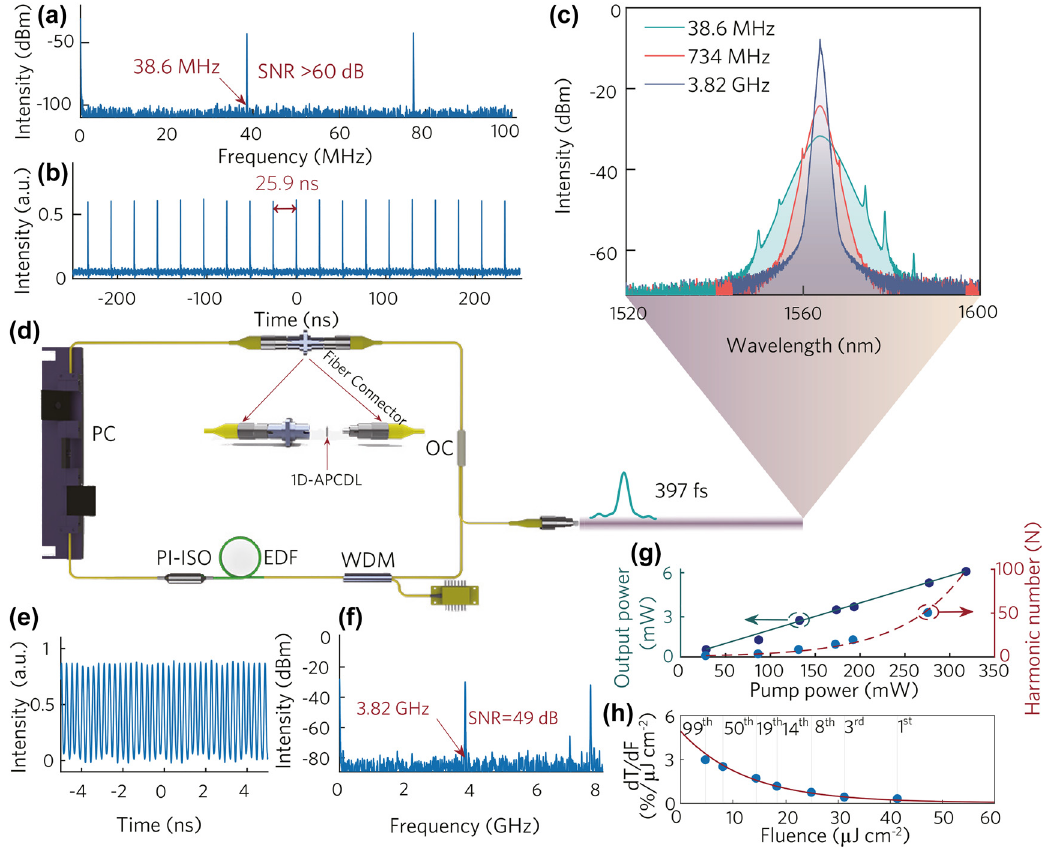
Figure 7: Application of 1D-APCDL in ultrafast fiber laser. (a) RF spectrum (fundamental frequency), (b) pulse train, (c) mode-locked spectra of different orders, (d) cavity schematic, (e) pulse train (99th), (f) RF spectrum, (g) the curve of output power and harmonic order varying with pump power, and (h) first derivative of nonlinear transmittance curve with respect to